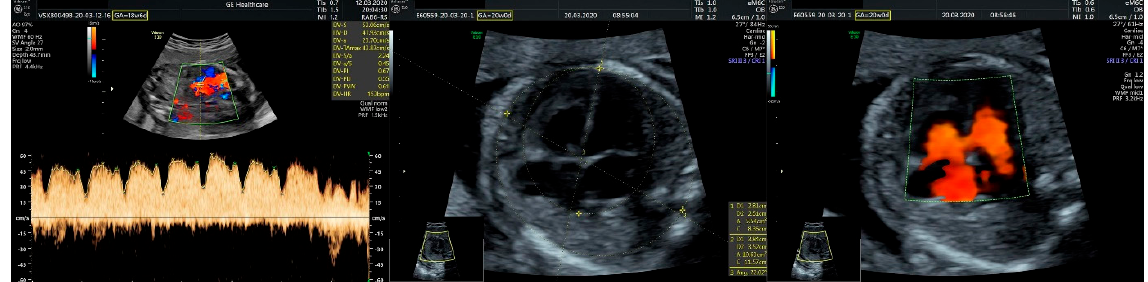
Figure 1. ( Left ): normal triphasic flow of the ductus venosus; ( middle ): mild cardiomegaly and a common four-chamber aspect of the heart; ( right ): membranous ventricular septal defect.